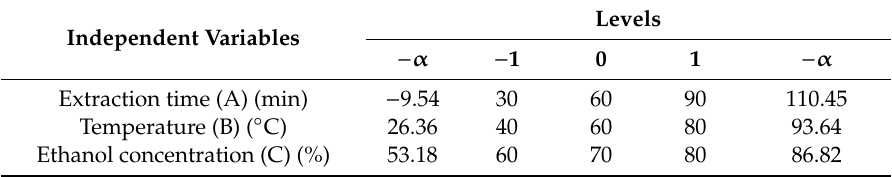
Table 4. Independent variables and their levels in central composite